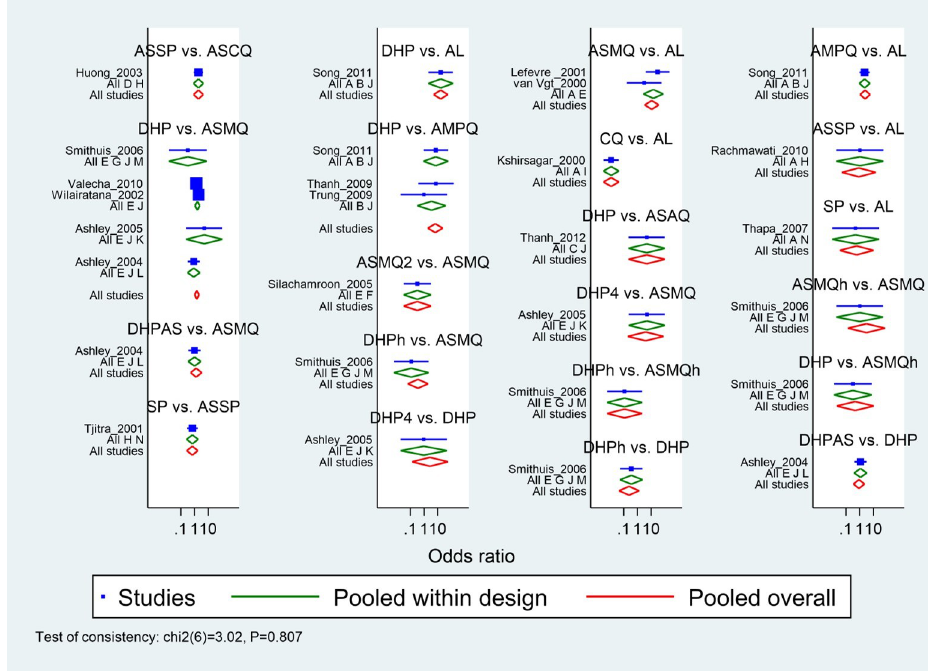
Fig 3. All direct and mixed comparisons.